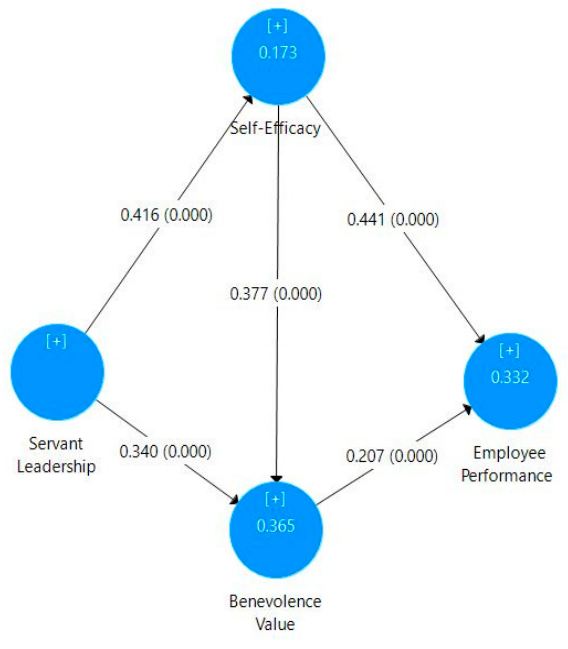
Figure 4. Structural model path coefficient and p values.